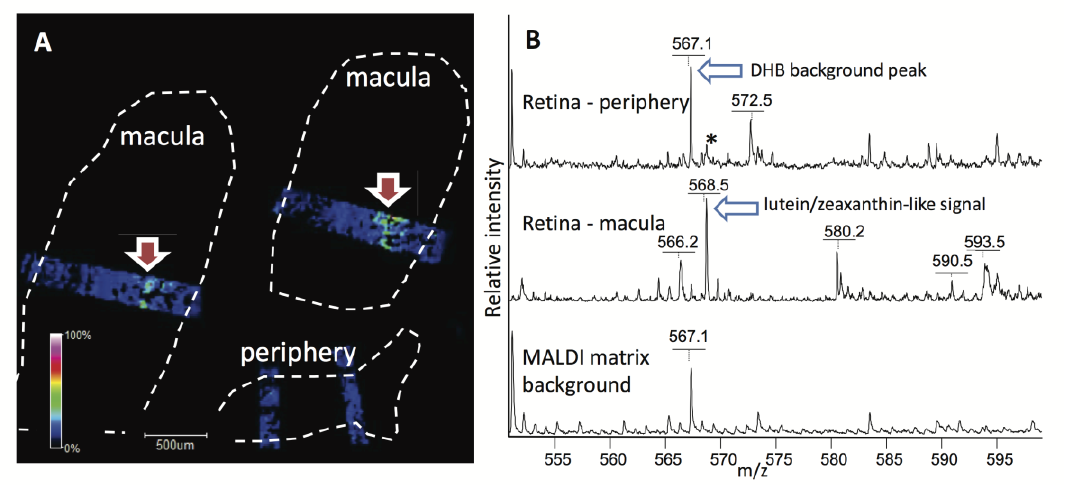
Figure 3. Lutein/zeaxanthin-like signal distributions in 10 μm thick sections of monkey retina detected using MSI. ( A ) Distribution of lutein/zeaxanthin-like signal in macula vs . periphery of retina. Only small rectangular areas in each retina section were examined (blue color). White and red colors represent highest relative signal intensities. Dashed line outlines areas occupied by tissue sections. ( B ) Representative mass spectra acquired from the examined retina regions. Asterisk marks likely matrix-related signal contributing to low intensity ubiquitous